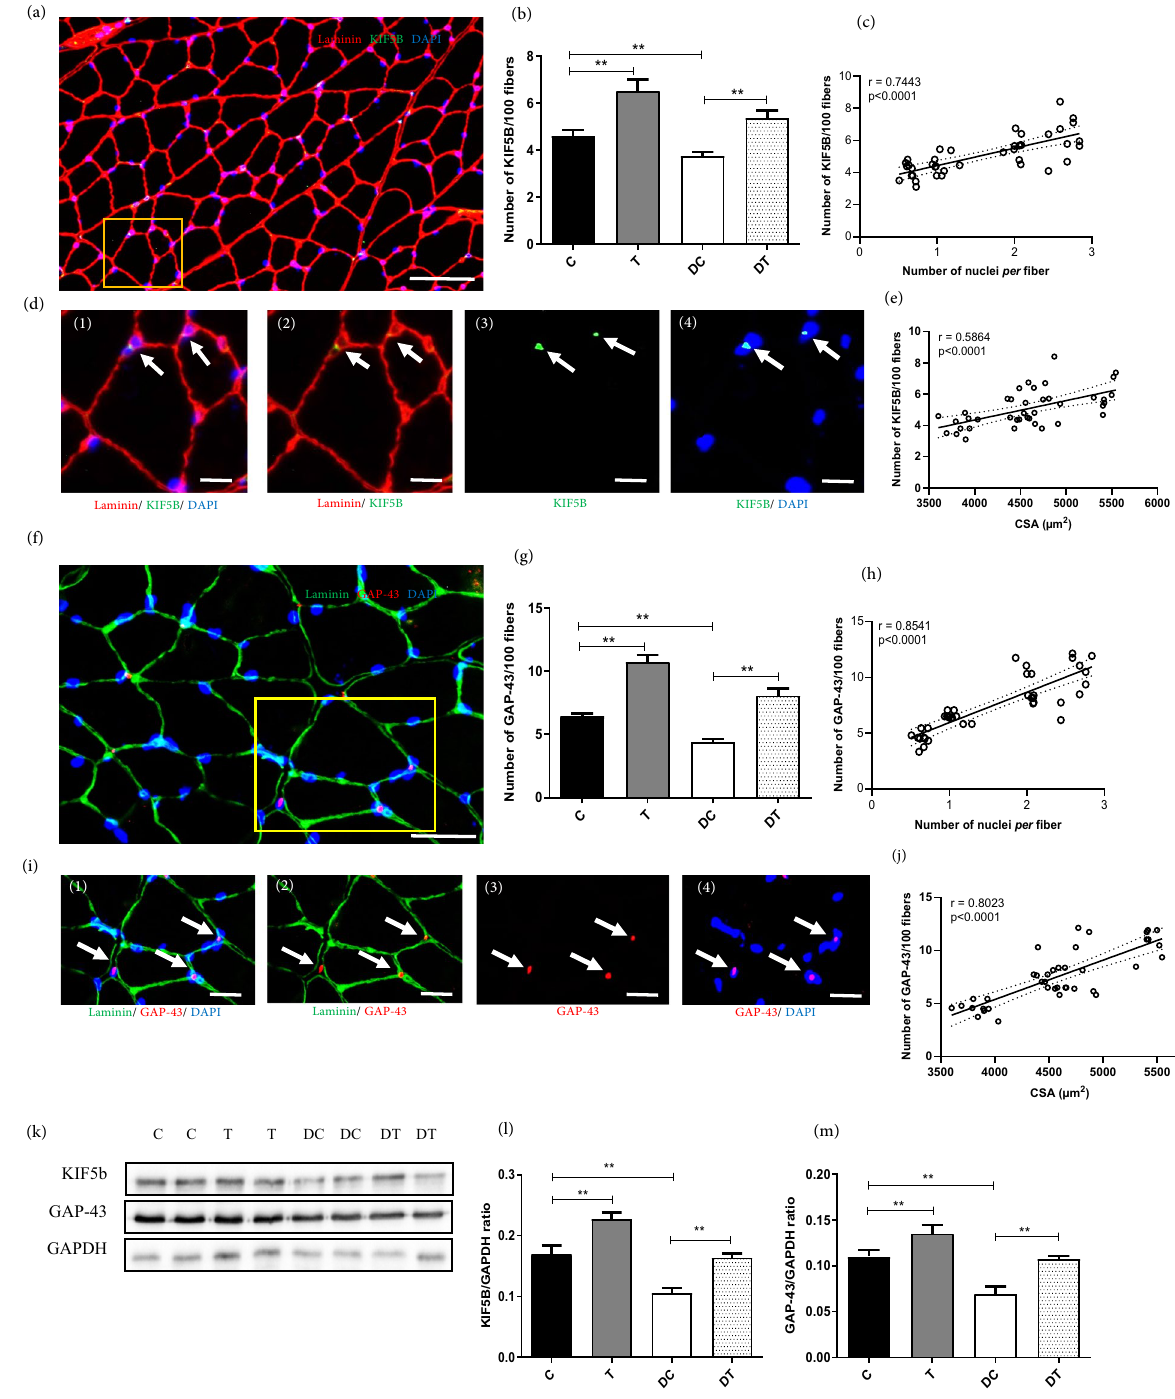
Figure 2. Kif5B and GAP-43 expression in different experimental groups. ( a ) Representative image of Kif5B analysis. ( e ) Number of Kif5B + /100 fibers. ( c ) Correlation between Kif5B + /100 fibers and the number of nuclei per fiber. ( d 1–4) Higher magnification of selected area (yellow box) in image ( a ) showing Laminin (red), Kif5B (green) and myonuclei (blue). ( e ) Correlation between Kif5B + /100 fibers and average gastrocnemius muscle CSA. ( f ) Representative image of GAP-43 analysis. ( g ) Number of GAP-43 + /100 fibers. ( h ) Correlation between GAP-43 + /100 fibers and the number of nuclei per fiber. (i 1–4) Higher magnification of selected area (yellow box) in image (f) showing Laminin (green), GAP-43 (red) and myonuclei (blue). ( j ) Correlation between GAP- 43 + /100 fibers and average gastrocnemius muscle CSA. ( k ) Representative Western blot images from different experimental groups. Expression of Kif5B ( l ), and GAP-43 ( m ) further demonstrated by Western blotting normalized to GAPDH. White bar = 50 µm. ** p < 0.001. Full gel-images are available in Supplementary Material. Statistical analysis was performed using the Graph-Pad Prism statistics software (Graph-Pad Software Inc., San Diego, CA, USA free demo version